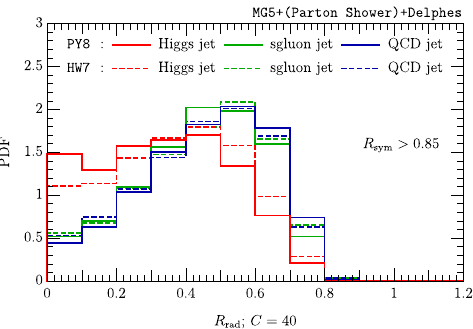
Figure 6 . The distribution of R rad for Higgs jet (red), sgluon jet (green), and QCD jet (blue) with an additional selection of R sym > 0 : 85. The solid (dashed) lines correspond to the jets of PY8 ( HW7 )